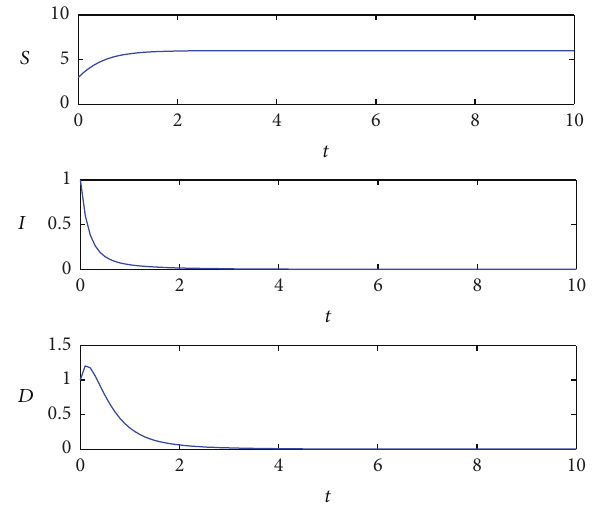
Figure 1: When 𝜏 = 0 , 𝑏 = 6 , 𝛼 = 𝑑 = 𝑘 = 1 , 𝑐 = 4 , and 𝑢 1 = 𝑢 2 = 2 , then 𝑅 0 = 0.8571 < 1 . Taking the initial value (3, 1,1) , then the solution (𝑆(𝑡),𝐼(𝑡),𝐷(𝑡)) approaches to the disease-free equilibrium = (6, 0,0) as 𝑡 → ∞ 𝐸 0